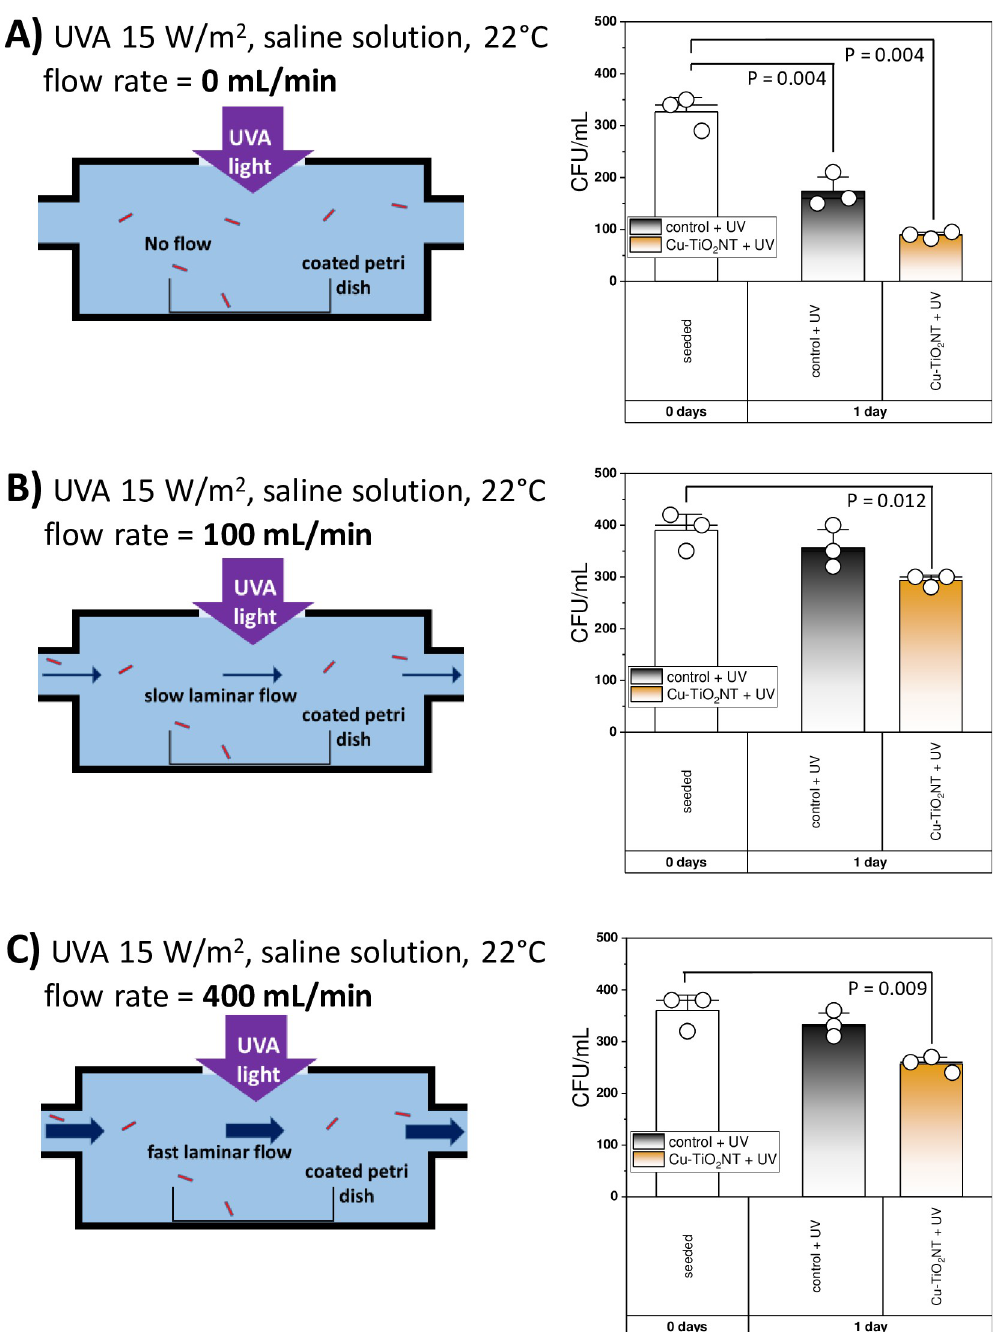
Fig 3. Survival of L . pneumophila in a laminar flow chamber in a petri dish illuminated with high intensity UVA light (15 W/m2). Volume of entire fluid was 2 L. Bacterium was grown overnight in suitable growth medium (overnight culture), which was diluted in a ratio of 1:30 into 2 L of the growth medium thus containing approximately 360 bacteria / mL (standard medium BCYE for Legionella with added cysteine). Diluted bacteria in saline solution were circulating for 24 hours at different rates of laminar flow. A) at 0 mL/min flow rate the number of bacteria is decreased for approximately 50%, from 327 ± 19to 173 ± 18(two-tailed P-value = 0.004, two-tailed t-test: t = 5.824 with 4 degrees of freedom) in uncoated petri dishes (black bars), and decreased for approximately 70%, from 327 ± 19to 93 ± 5(two-tailed P-value = 0.004, two-tailed t- test: t = 12.237 with 4 degrees of freedom) in Cu-TiO 2 NT coated petri dishes (orange bars); B) at 100 mL/min laminar flow rates the significant differences of approximately 25% CFU reduction in 1 day were observed only in copper doped TiO 2 nanotube coated petri dishes (orange bars, two-tailed P-value = 0.012, two-tailed t-test: t = 4.422 with 4 degrees of